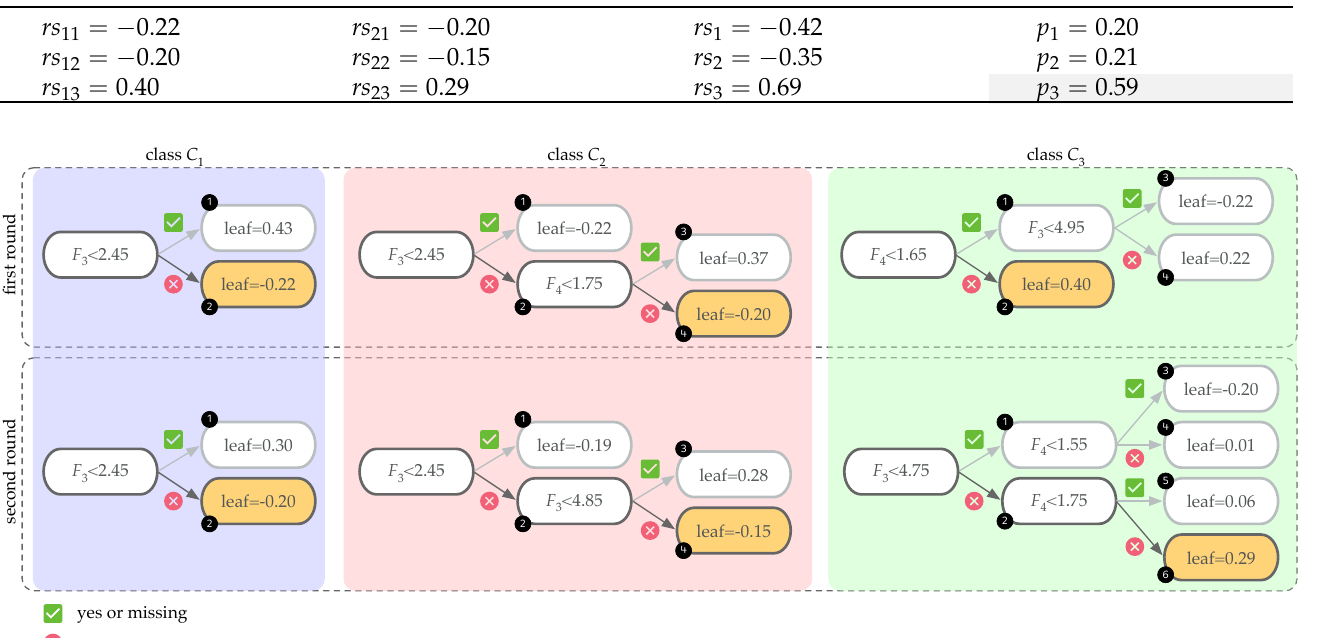
Figure 6. Forest of R · l = 2 · 3 = 6 trees, where R = 2 is the number of boosting rounds and l = 3 is the number of classes. Given a specific sample with features F 1 = 10.24, F 2 = 3.57, F 3 = 5.02, and F 4 = 2.38, the decision rules of the forest predict that this sample is associated with the leaves { 2,4,2 } of the first round and to the leaves { 2,4,6 } in the second